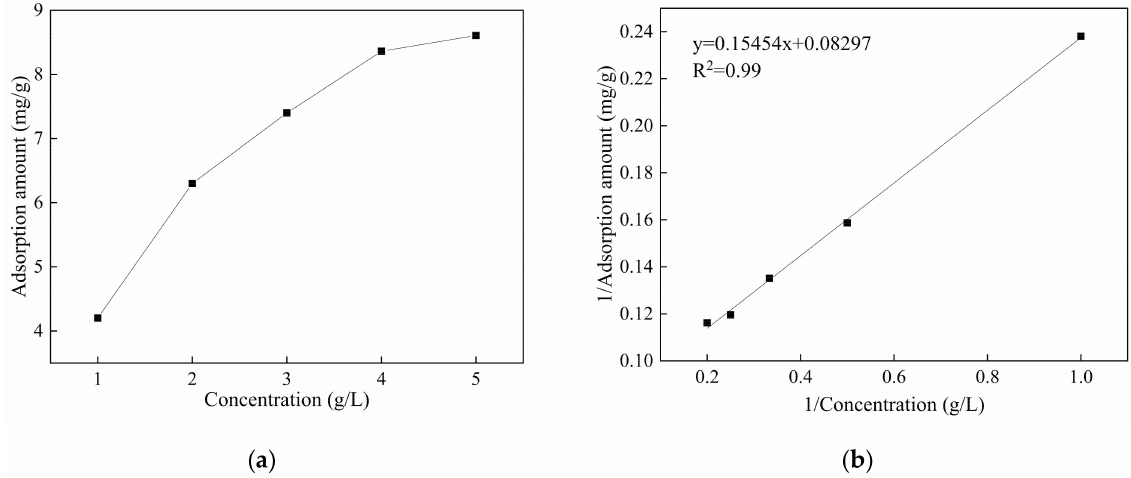
Figure 10. ( a ) The relationship between adsorption amount of TP on cement surface (in mg per g of cement) and TP concentration, and ( b ) the model of Langmuir adsorption